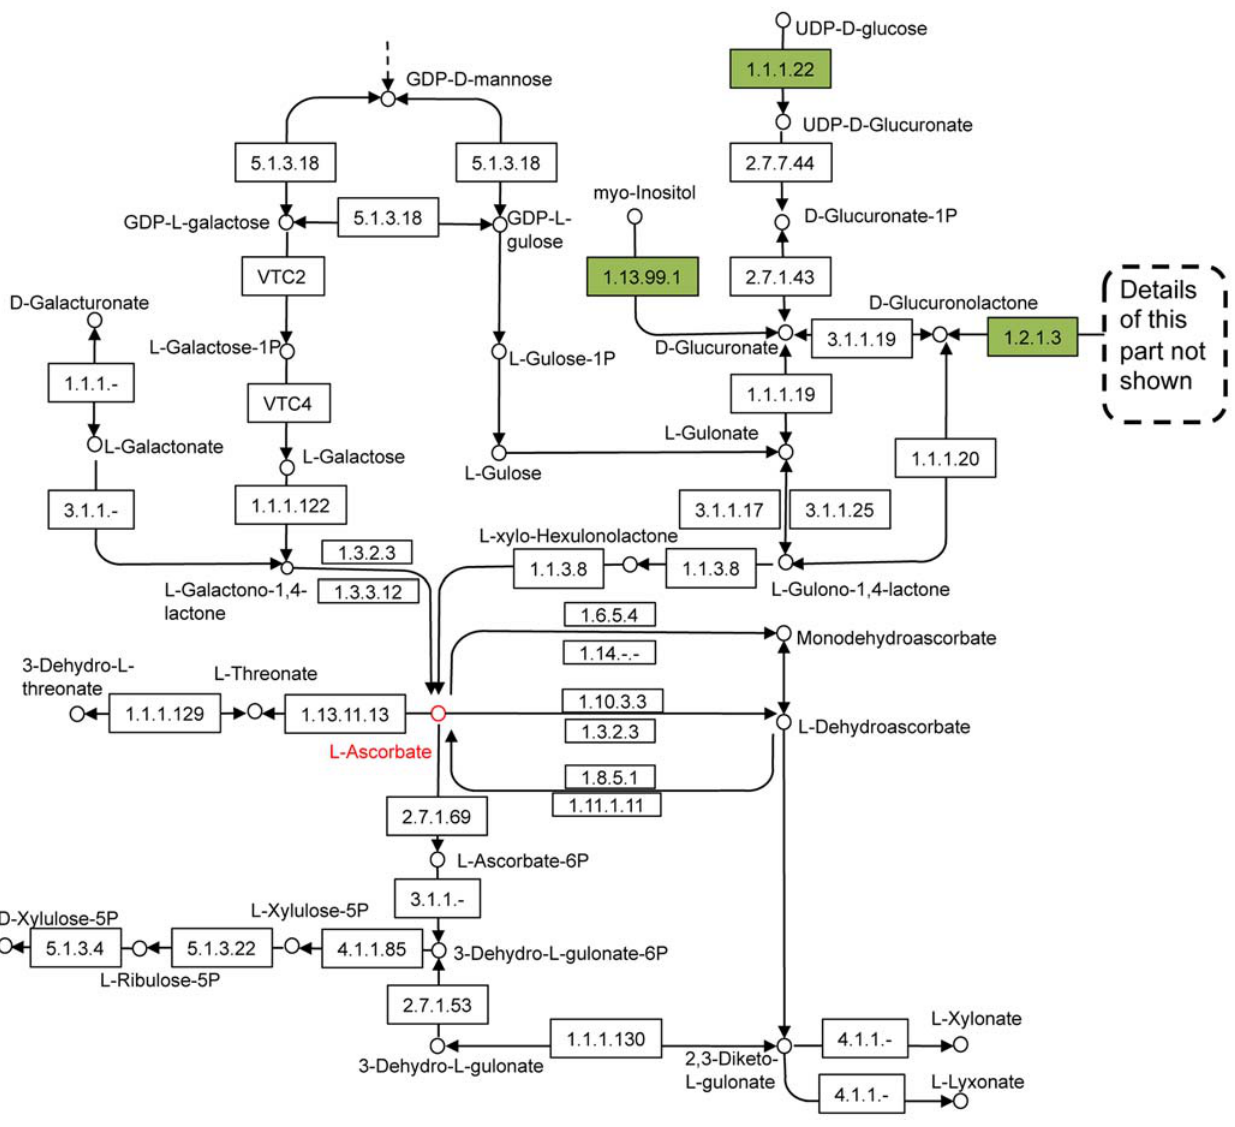
Figure 3. The ascorbate and aldarate metabolism pathway, eliminated by MinPath. The diagram was prepared based on the corresponding KEGG pathway (ID=00053), and only part of the pathway is shown for clarity. The three enzymes that are annotated in the human genome are highlighted in green, even though none of these enzymes are unique to this pathway.